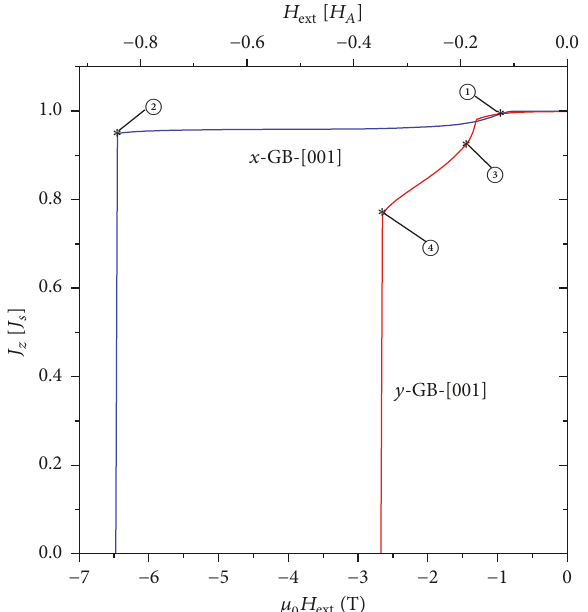
Figure 16: Calculated demagnetization curves for 𝑥 -GB with 𝐻 ext // [001] and 𝑦 -GB with 𝐻 ext // [001] and a GB thickness of 8 nm. The details of the magnetic states A – D are shown in Figures 17 and 18.